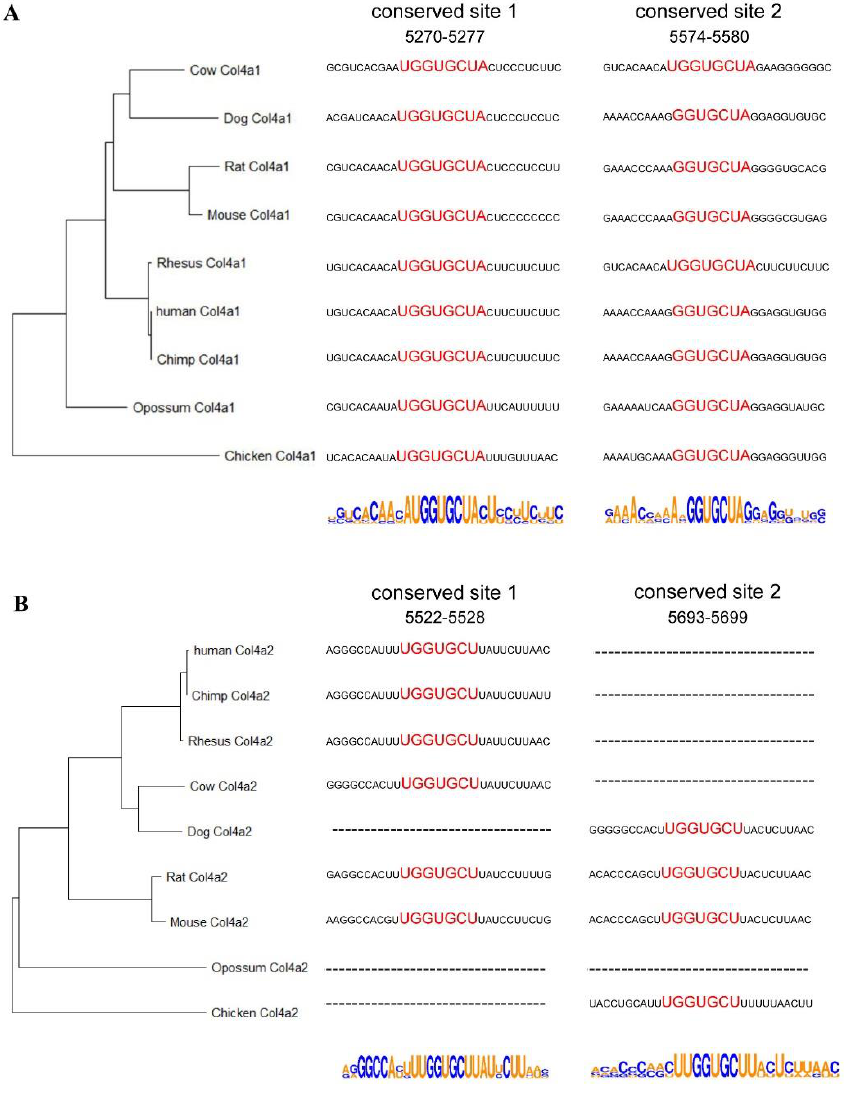
Figure 2. Analysis of Col4a1 and Col4a2 3 ’ UTRs and miR-29 binding sites. ( A , B ) Phylogenetic tree constructed from the 3 ’ UTRs of Col4a1 and Col4a2 in multiple species. Analysis of miR-29 binding sites and flanking sequences in the 3 ’ UTRs of Col4a1 and Col4a2 in multiple species.